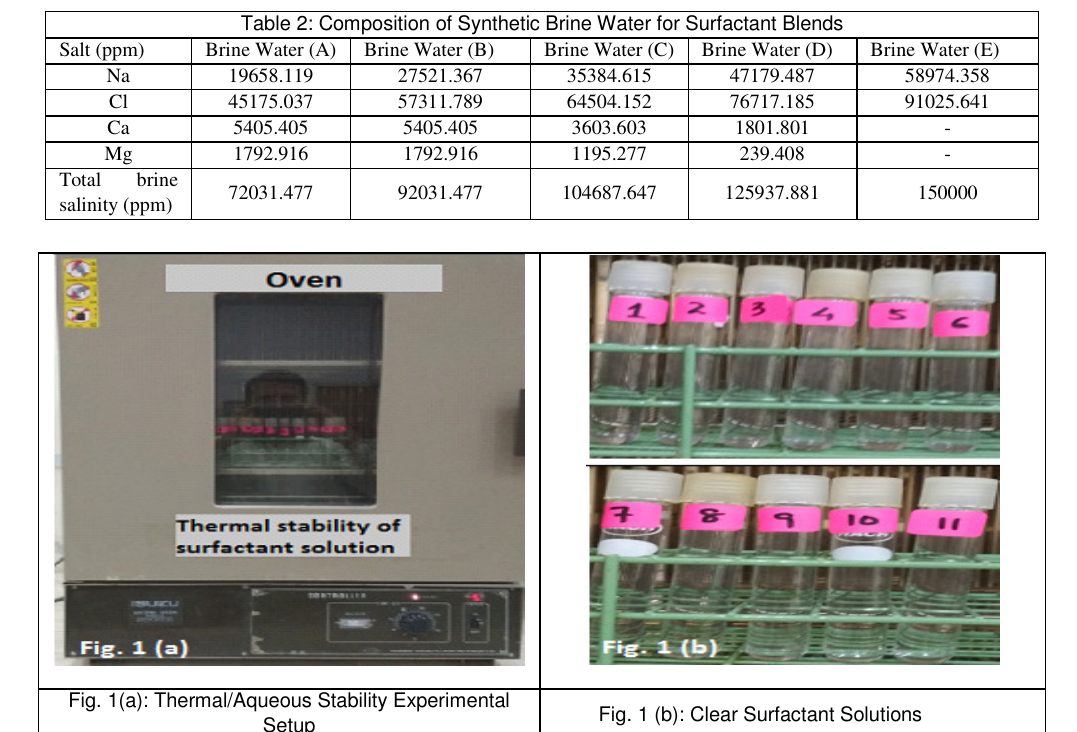
Fig. 1 (b): Clear Surfactant Solutions